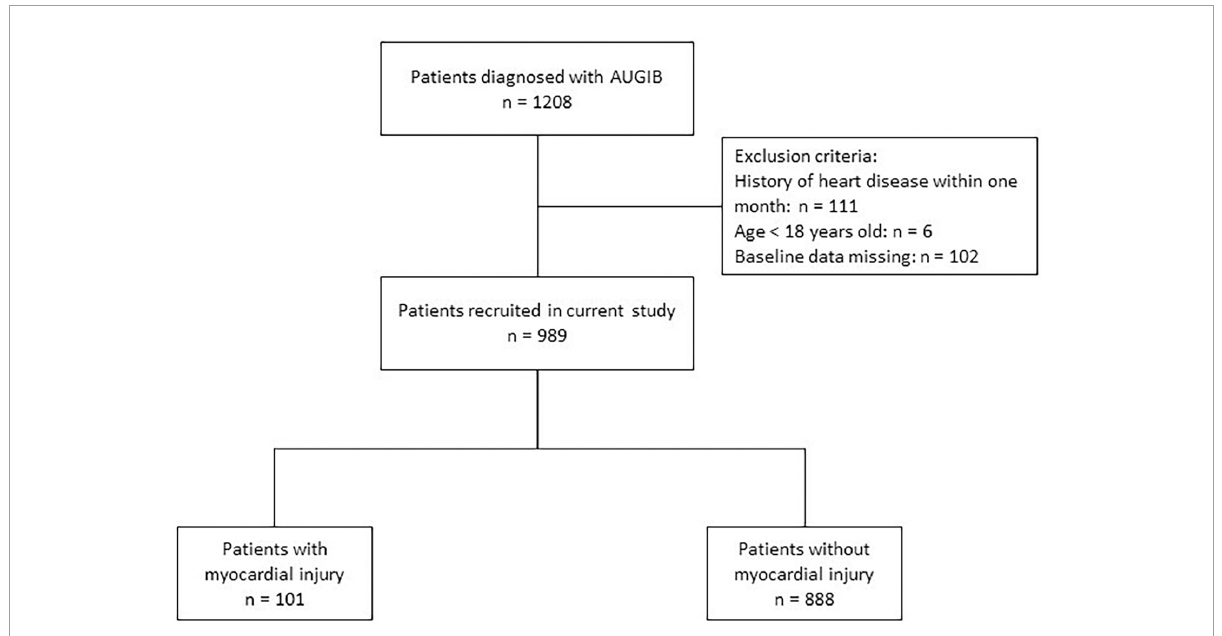
FIGURE1 Flowchart of the study. AUGIB, acute upper gastrointestinal